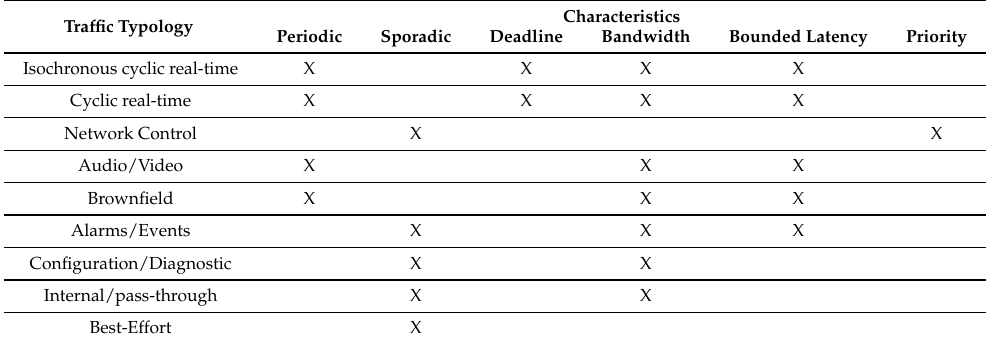
Table 4. Industrial traffic